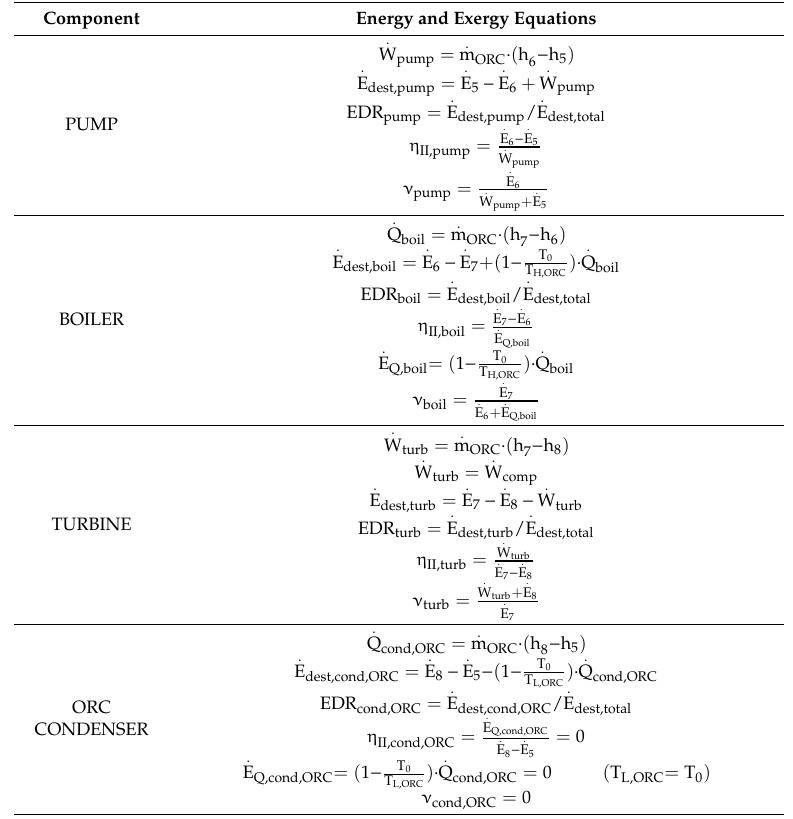
Table 5. Equations for ORC cycle components in combined ORC-single evaporator VCR